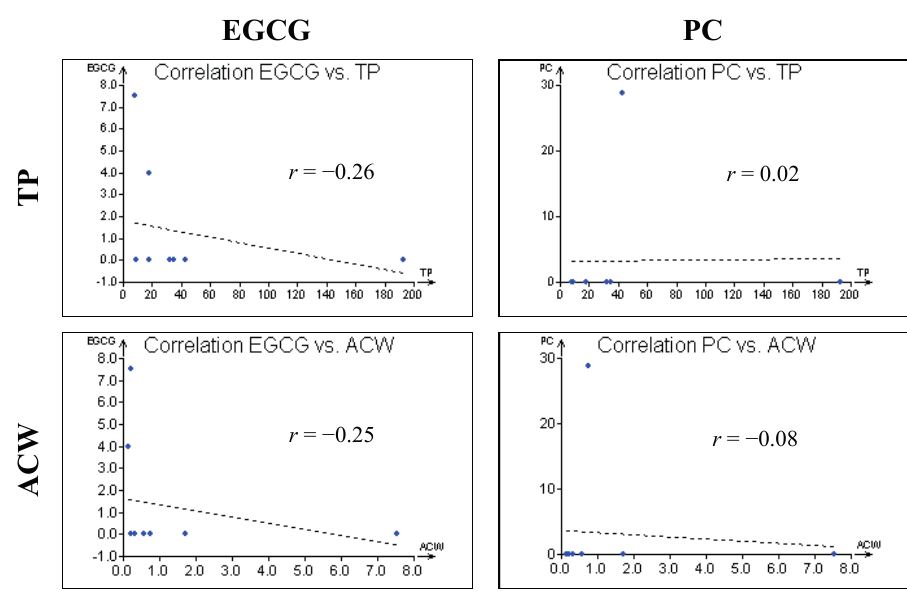
Figure 3. Graphic illustration of correlations between antioxidant capacities of either total phenolic contents (TP), or water soluble compounds (ACW) and amounts of selected phenolic compounds (GA—gallic acid; HBA—4-hydroxybenzoic acid; C—catechin